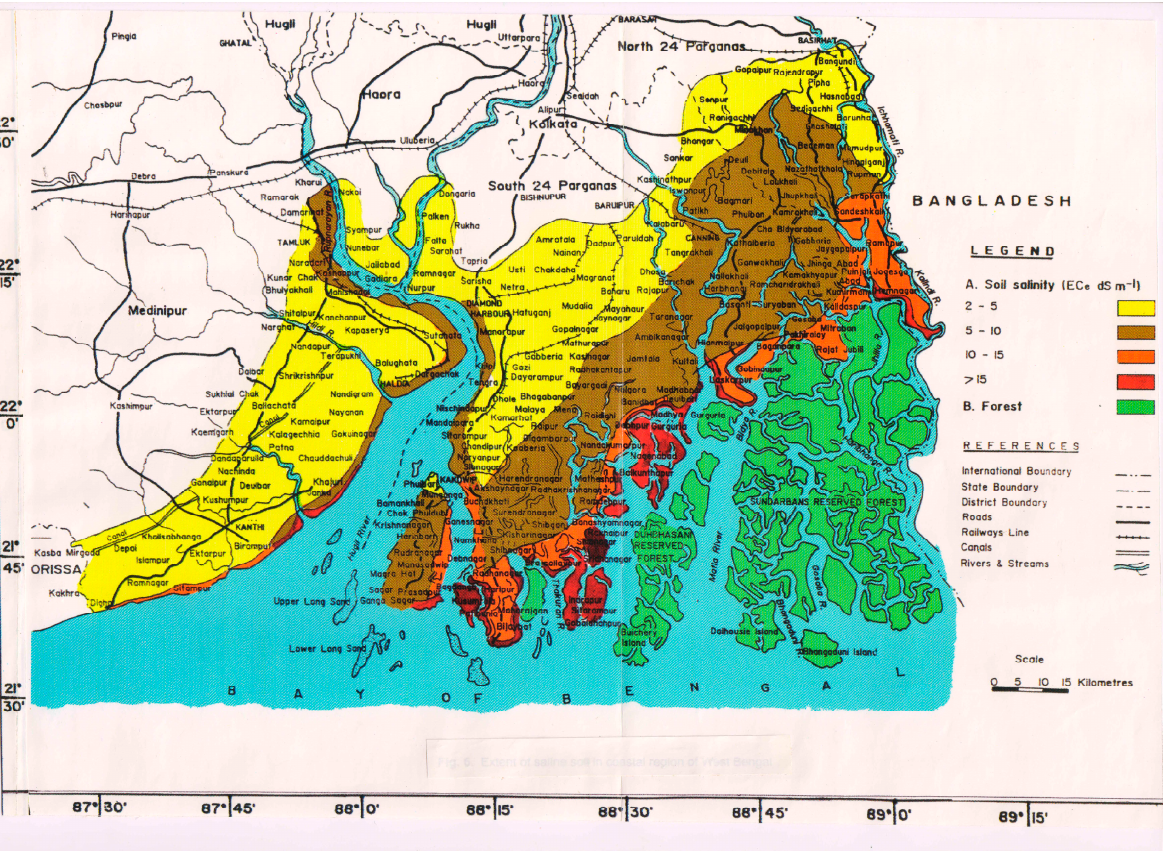
Figure 1. The Ganges Delta covering coastal areas of Bangladesh and West Bengal, India. Source [23].